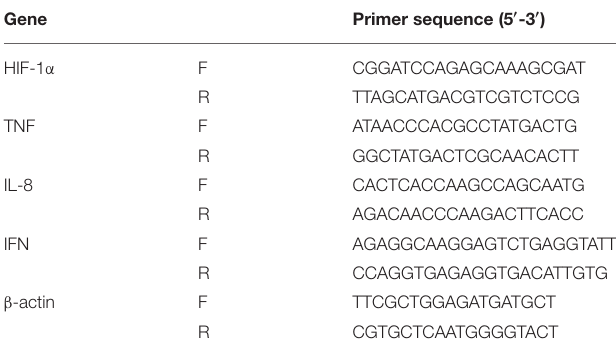
TABLE 1 | Primers for qPCR identification of HIF-1 α , TNF, IL-8, IFN, and β